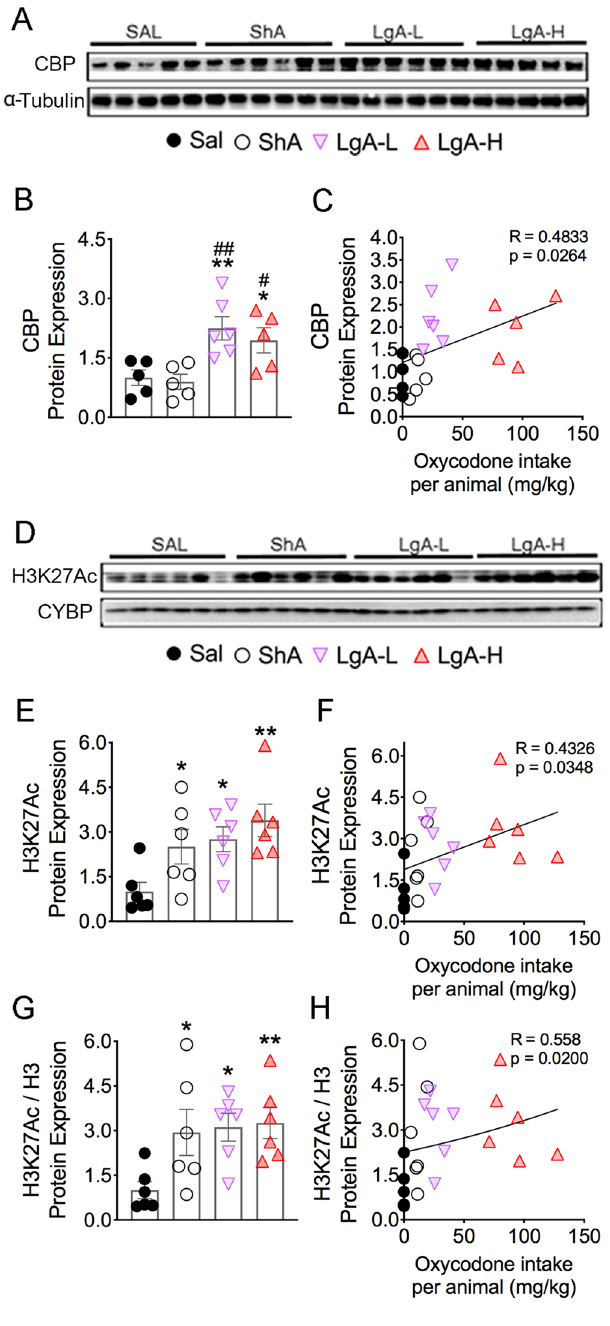
Figure 6. Differential effects on the protein expression of CBP and H3K27Ac after oxycodone SA. ( A , D ) Images of western blot and quantification of ( B ) CBP and ( E ) H3K27Ac protein levels. ( B ) CBP protein levels display significant increases in LgA groups. The protein levels of ( E ) H3K27Ac and ( G ) H3K27Ac/H3 protein were significantly increased in all drug groups. The regression analyses of ( C ) CBP, ( F ) H3K27Ac, and ( H ) H3K27Ac/H3 correlates with the amount of oxycodone taken (n = 5–6 Sal; n = 5–6 ShA; n = 6 LgA-L; n = 5–6 LgA-H). Key to statistics: *, ** = p < 0.05, 0.01, respectively, in comparison to Sal rats; #, ## = p < 0.05, 0.01, respectively, in comparison to ShA rats. Statistical analyses are as described in Fig.